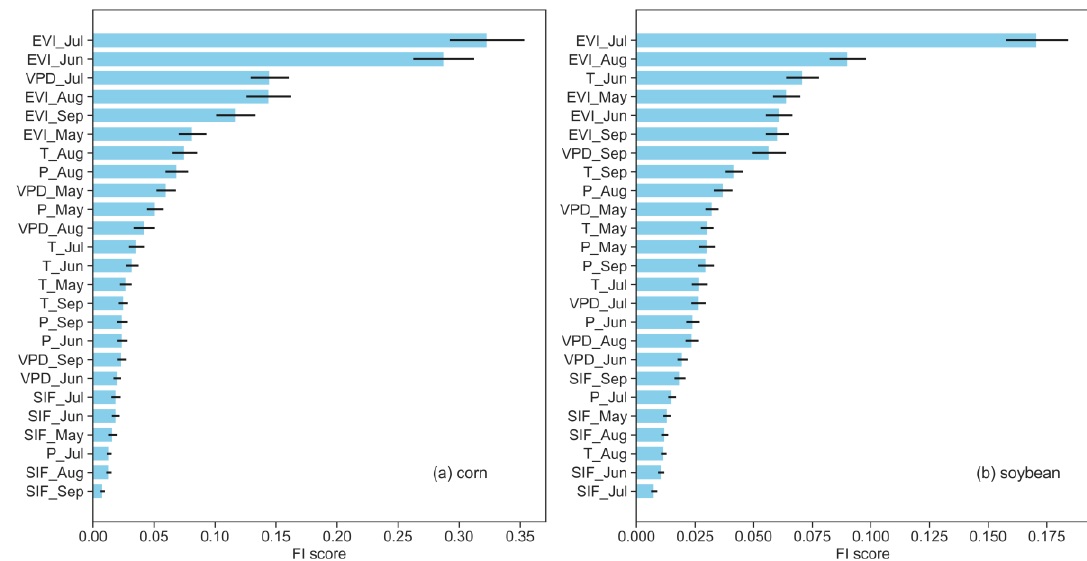
Figure 7. Feature importance (FI) scores of predictors in the ‘EVI + SIF + Climate’ model for corn ( left ) and soybean ( right ). Values of the x-axis are feature importance scores, and a variable with a larger FI score carries more importance in predicting the crop yield (P = precipitation; T = temperature; VPD = vapor pressure deficit).